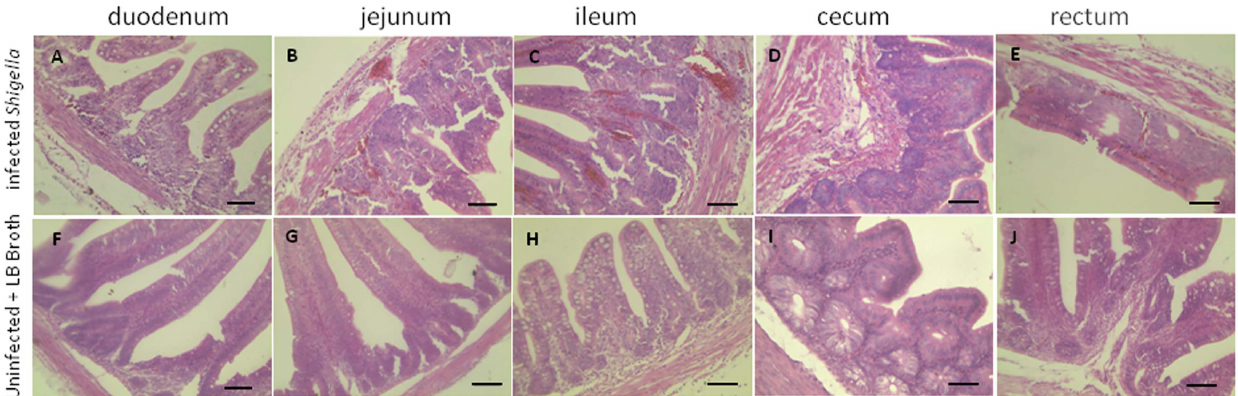
Figure 3. Histopathology of the intestine of one-day-old SPF chickens infected with the Shigella strain ZD02 via ligated intestinal loop. The duodenum, jejunum, ileum, and cecum from Shigella -infected chickens showed congestion, edema, and neutrophil infiltration (A–E, respectively). No significant pathological changes were noticed in the uninfected controls (F–J, respectively). The sections were stained with hematoxylin and eosin. Representative pictures are shown. Scale bars=50 m m.